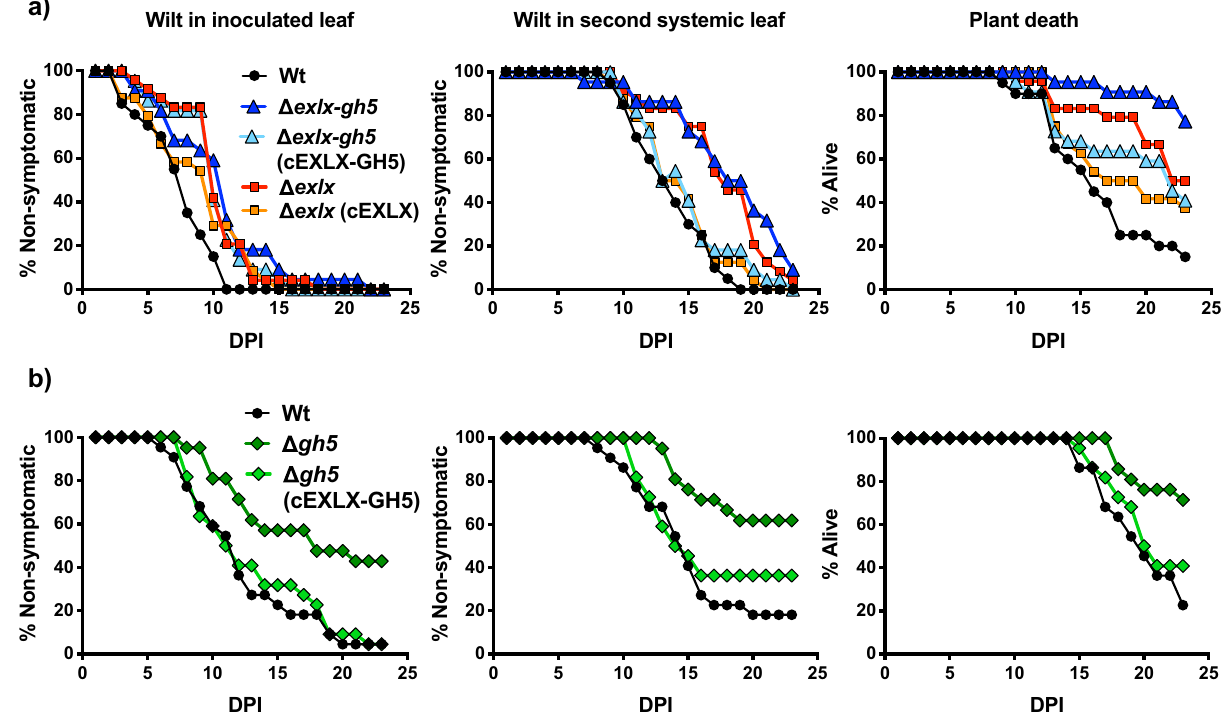
Figure 4. Contribution of the Erwinia tracheiphila exlx–gh5 locus to wilt symptom development and plant death. ( a ) In planta inoculation experiment comparing virulence of Wt, Δ exlx–gh5, Δ exlx–gh5 (cEXLX-GH5), Δ exlx and Δ exlx (cEXLX) strains. ( b ) A second independent in planta inoculation experiment comparing virulence of Wt, Δ gh5, and Δ gh5 (cEXLX-GH5) strains. In both ( a ) and ( b ), inoculated plants were monitored for first appearance of wilt symptoms in the inoculated leaf, first appearance of systemic wilt symptoms in a second non-inoculated leaf and plant death for 23 days post inoculation (DPI). Summary statistics are in Table 1 and statistical analyses are in Table